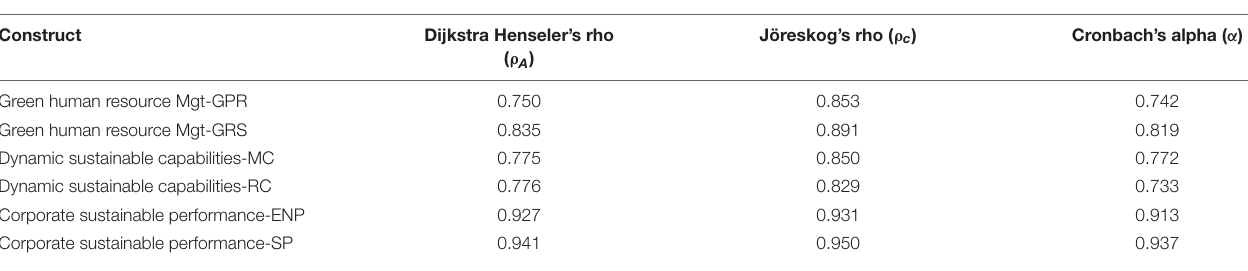
TABLE 2 | Reliability